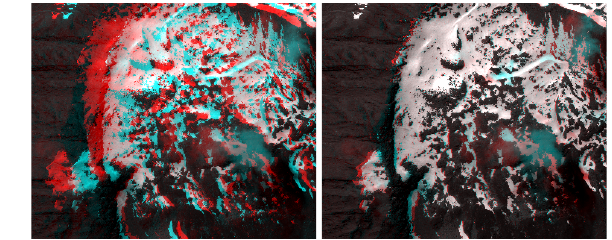
Figure 3. Anaglyphs generated from epipolar grids from PHR Mont-Blanc case (see section 4.1), with h as an average elevation of 2319 meters (left) and with h sampled from SRTM at 30 meters resolution (right). One can clearly see the reduced disparity between both